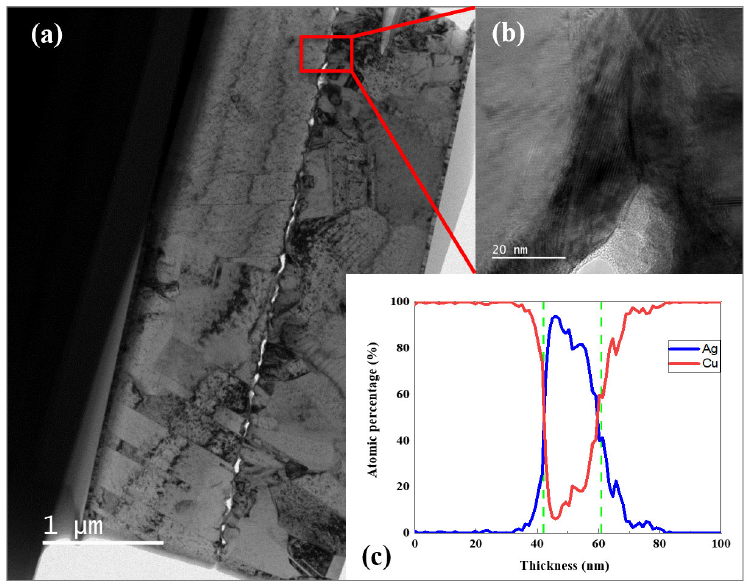
Figure 7. TEM and EDS analysis of Cu/Ag ‐ Ag/Cu bonding at 180 °C: ( a ) TEM image of bonding interface, ( b ) magnified TEM image of the red box, and ( c ) EDP profile across the interface